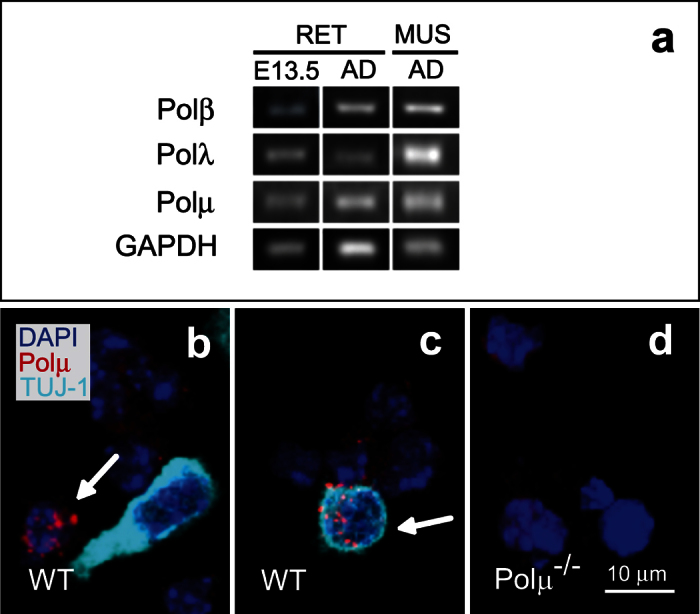
Polμ is present in E13.5 mouse retinas.(a) RT-PCR was used to detect mRNAs corresponding to the DNA repair polymerases β, λ, and μ in WT E13.5 and adult retinas and in adult muscle (AD, adult; RET, retina; MUS, muscle). (b,c) Polμ protein was detected by immunofluorescence in dissociated WT retinal cells. In some cases, Polμ nuclear foci (red; arrow) were present in cells displaying TUJ-1 neuronal staining (cyan). Cell nuclei were stained with DAPI (blue). (d) Dissociated Polμ−/− retinal cells were used as a negative control.